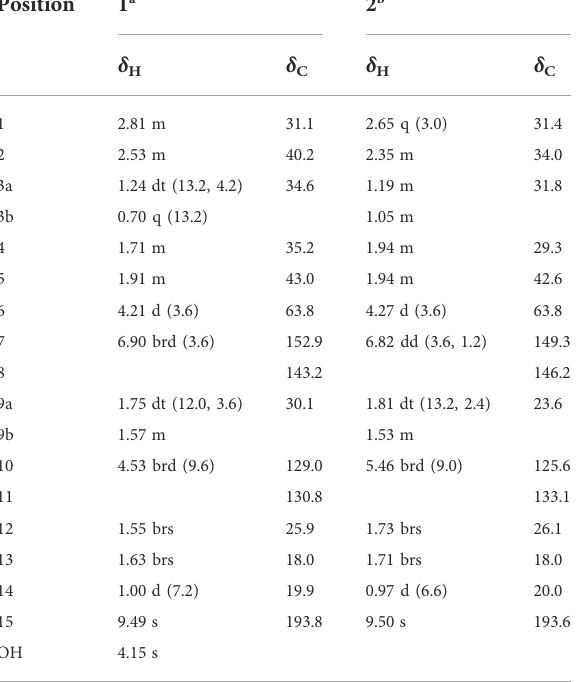
TABLE 1 1H (600 MHz) and13C NMR (150 MHz) data of 1 and 2 ( δ in ppm, J in Hz).